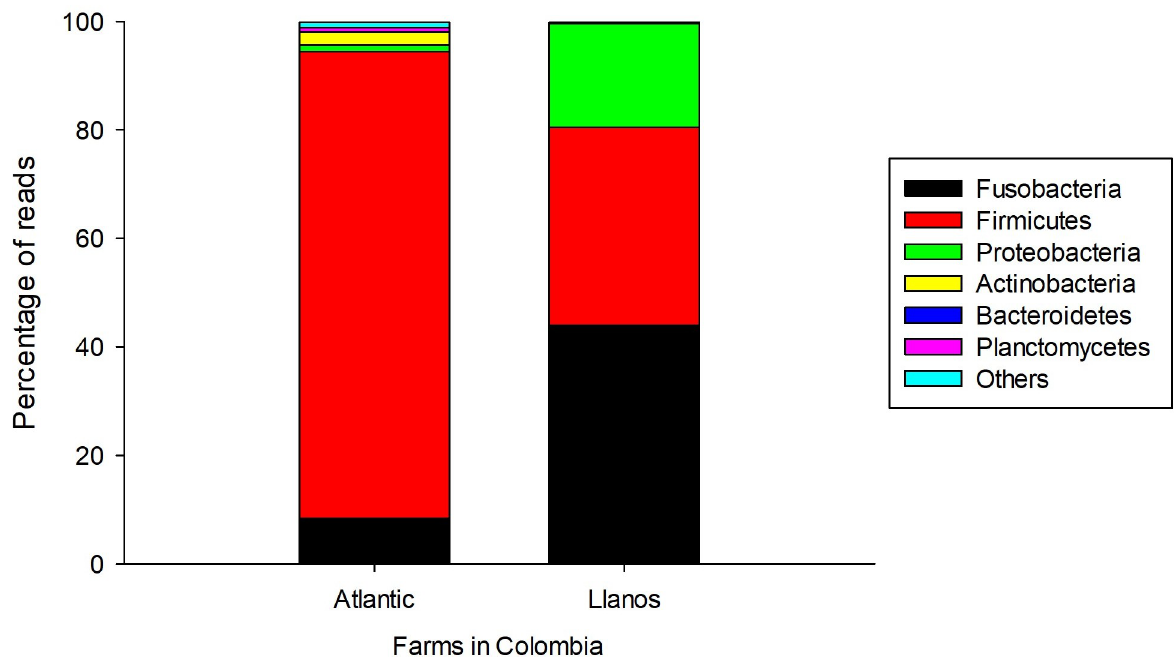
Fig 2. Relative abundance of intestinal bacteria phyla of Nile tilapia ( O . niloticus ) from two Colombian aquaculture farms (Atlantic and Llanos).